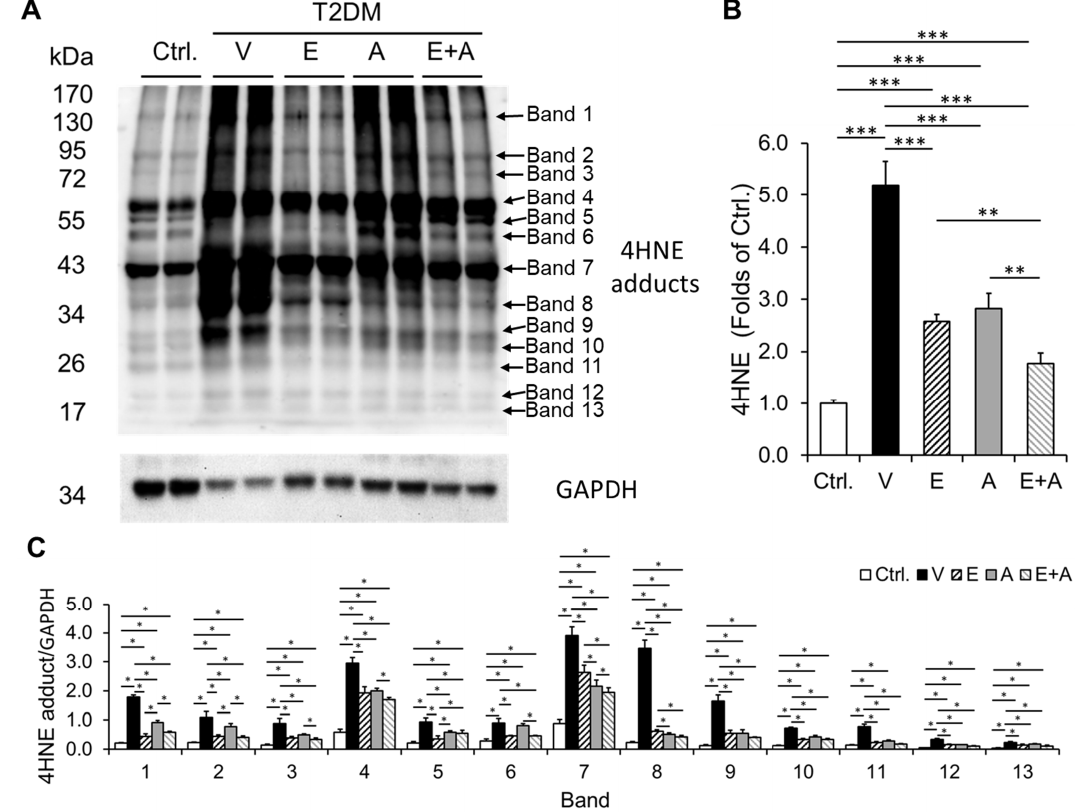
Figure 5. Immunoblotting band images of 4HNE protein adducts and their quantitation data in diabetic ALDH2*2 mutant mice exhibiting HFpEF with vehicle, EMP, Alda-1 and EMP + Alda-1 treatments. Western blot gel images of 4HNE protein adducts and the loading control, GAPDH of cardiac tissue samples from Ctrl, V, E, A and E +A groups ( A ), their densitometric quantification data ( B ) and the individual 4HNE protein adduct bands ( C ) were shown. Data are presented as mean ± standard error of the mean (SEM). n = 4. ** p < 0.01 and *** p < 0.001 refer to the difference between individual